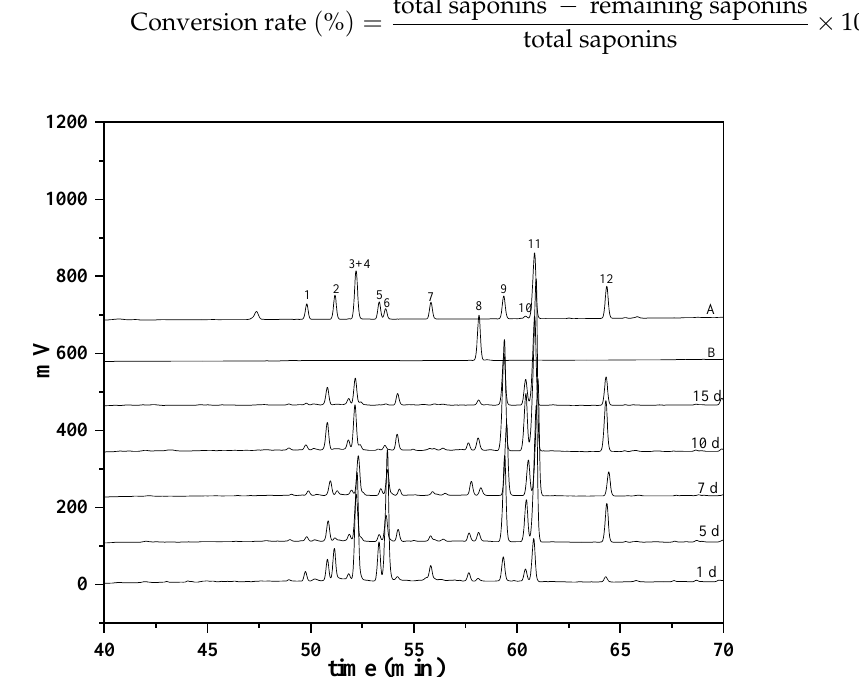
Figure 2. HPLC analysis of dynamic change of major saponins in PNF during biotransformation process by C. xylophilum . Twelve authentic saponins (A, B). The peaks: notoginsenoside Fa (1); ginsenoside Rb 1 (2); notoginsenoside Fc (3); ginsenoside Rc (4); ginsenoside Rb 2 (5); ginsenoside Rb 3 (6); ginsenoside Rd (7); Gpy17 (8); notoginsenoside Fe (9); ginsenoside Rd 2 (10); notoginsenoside Fd (11); ginsenoside F 2 (12). Major saponins in PNF transformated by C. xylophilum for different days.